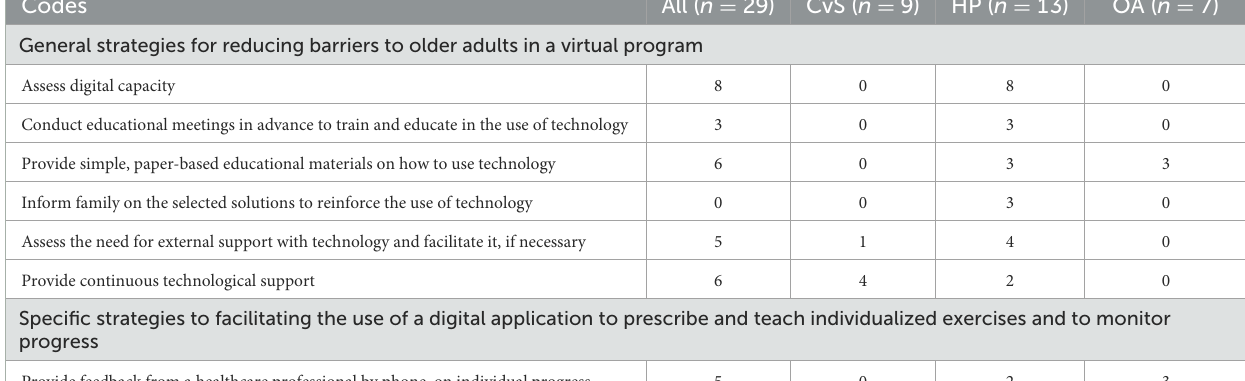
TABLE 2 Description and frequency of the main strategies (codes) suggested by the participants for implementing a virtual exercise program, grouped into four main categories.